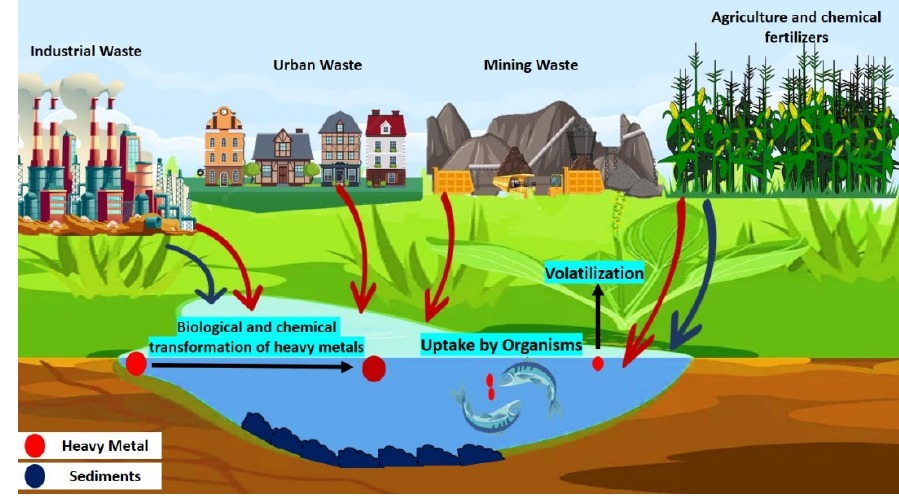
Figure 1. Anthropogenic sources of Cr (VI).